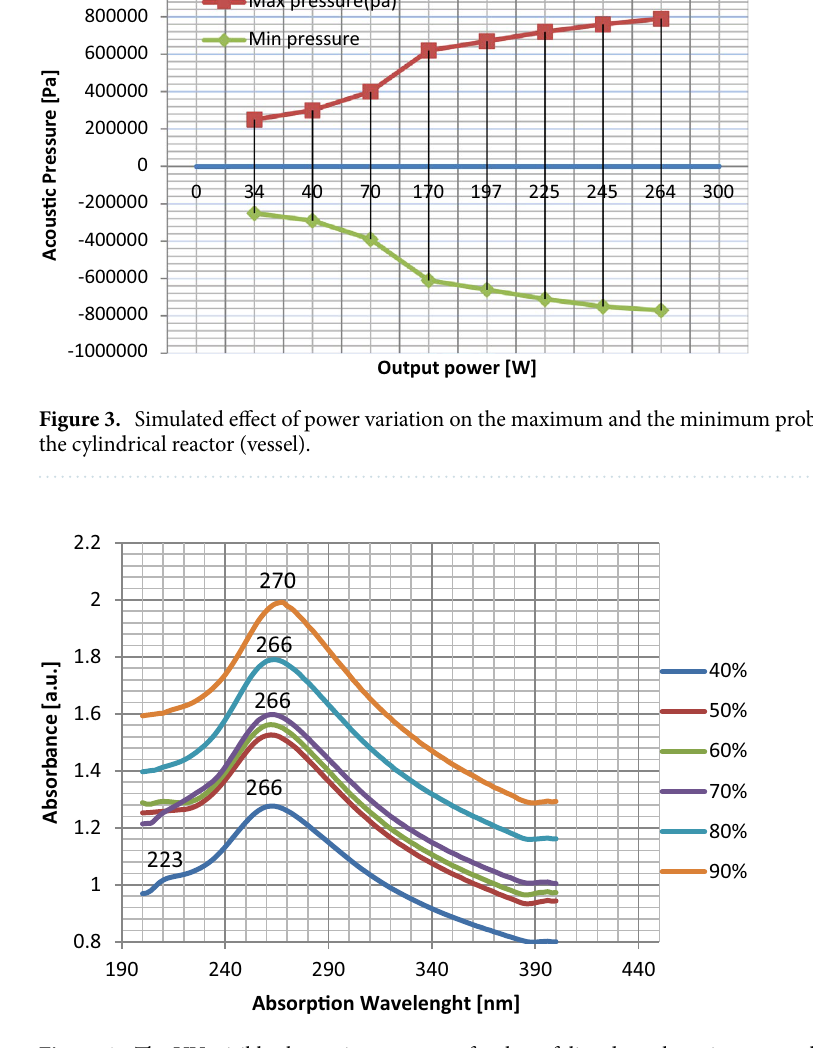
Figure 4. The UV–visible absorption spectrum for the exfoliated graphene in water–ethanol for different sonicating